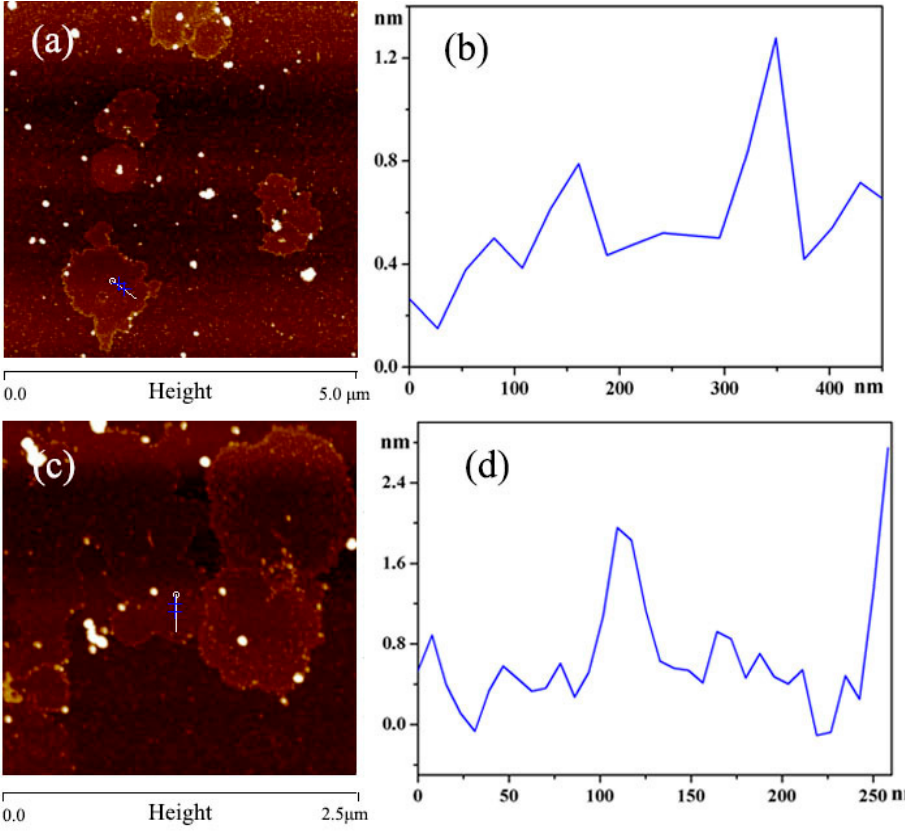
Figure 2. AFM images of graphene: ( a , c ) 2D morphologies of graphene with different magnifications; ( b , d ) height images of graphene with different magnifications.